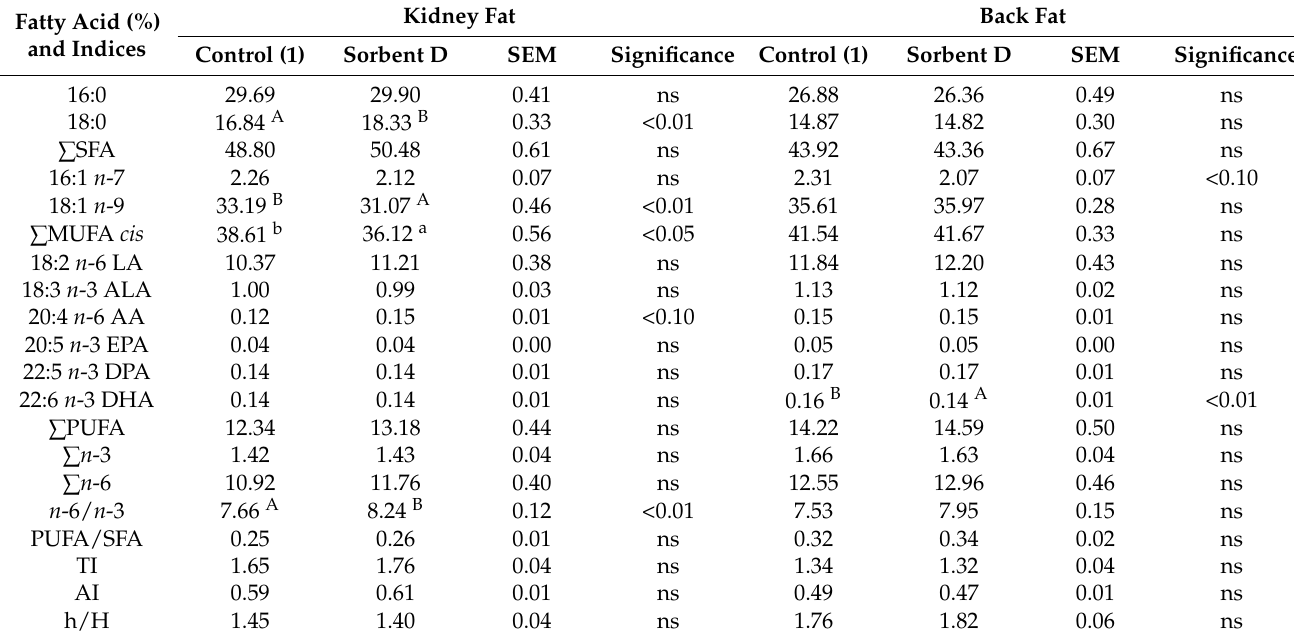
Table 2. Composition of fatty acid (% of total fatty acids) of kidney fat and back